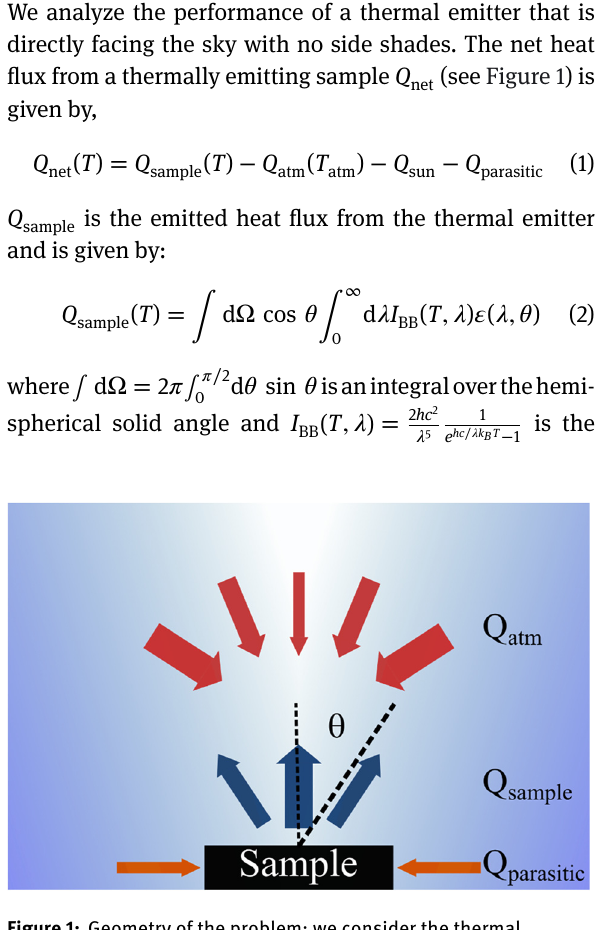
Figure 1: Geometry of the problem: we consider the thermal emission of a sample that can be either spectrally selective or a , cools it blackbody. The heat flux radiated by the sample Q sample down. The sample absorbs thermal radiation from the atmosphere Q atm . The thermal emissivity of the atmosphere 𝜀 atm depends on the angle from the sample’s normal. The sample is subjected to . The net radiation parasitic heating from its environment Q parasitic determines the equilibrium temperature of the sample. Our goal is to design the angular absorption/emission of the sample to minimize absorption of thermal radiation from the atmosphere by introducing angular selective